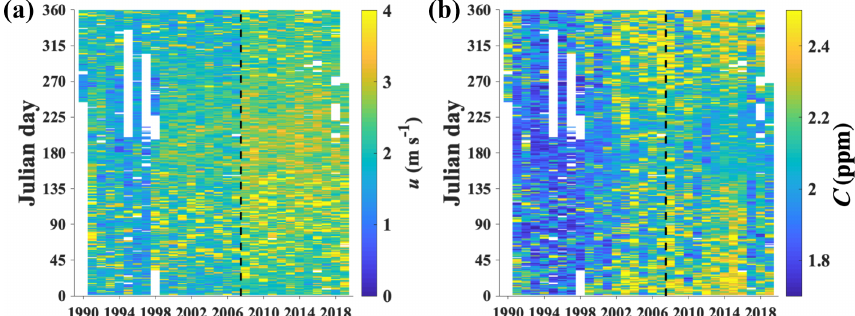
Figure 3. (a) Daily mean wind speed, u , and (b) concentration, C . Data key is shown in the figure. The WCS upgrade on January 2008 is shown by a dashed black line. Figure S7 shows the raw dataset.